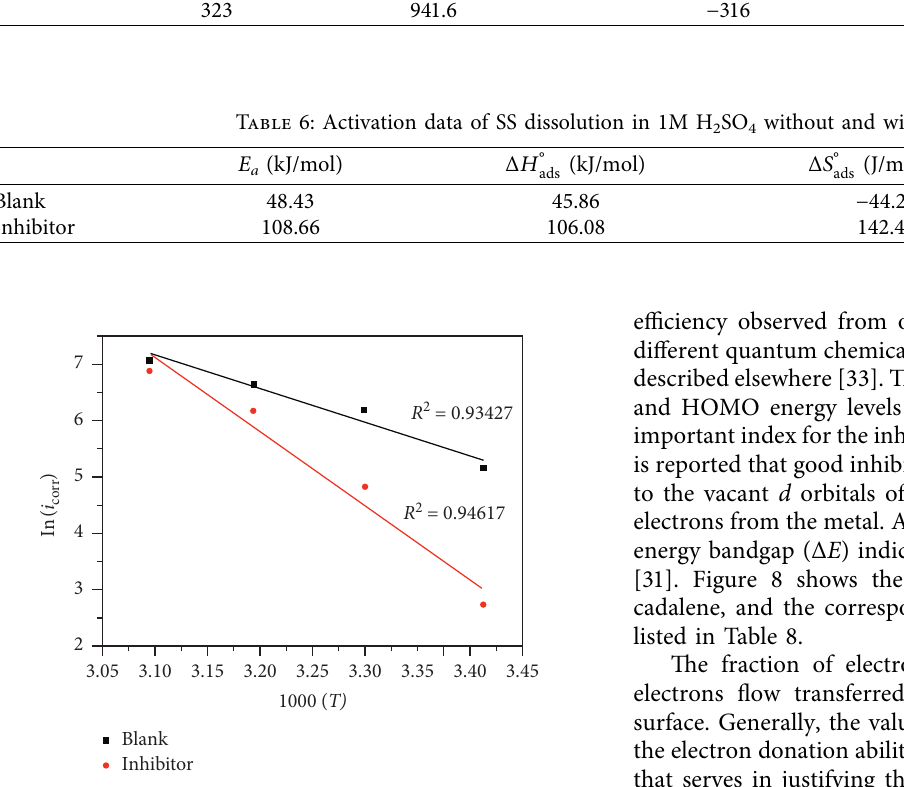
2 SO 4 in the absence and